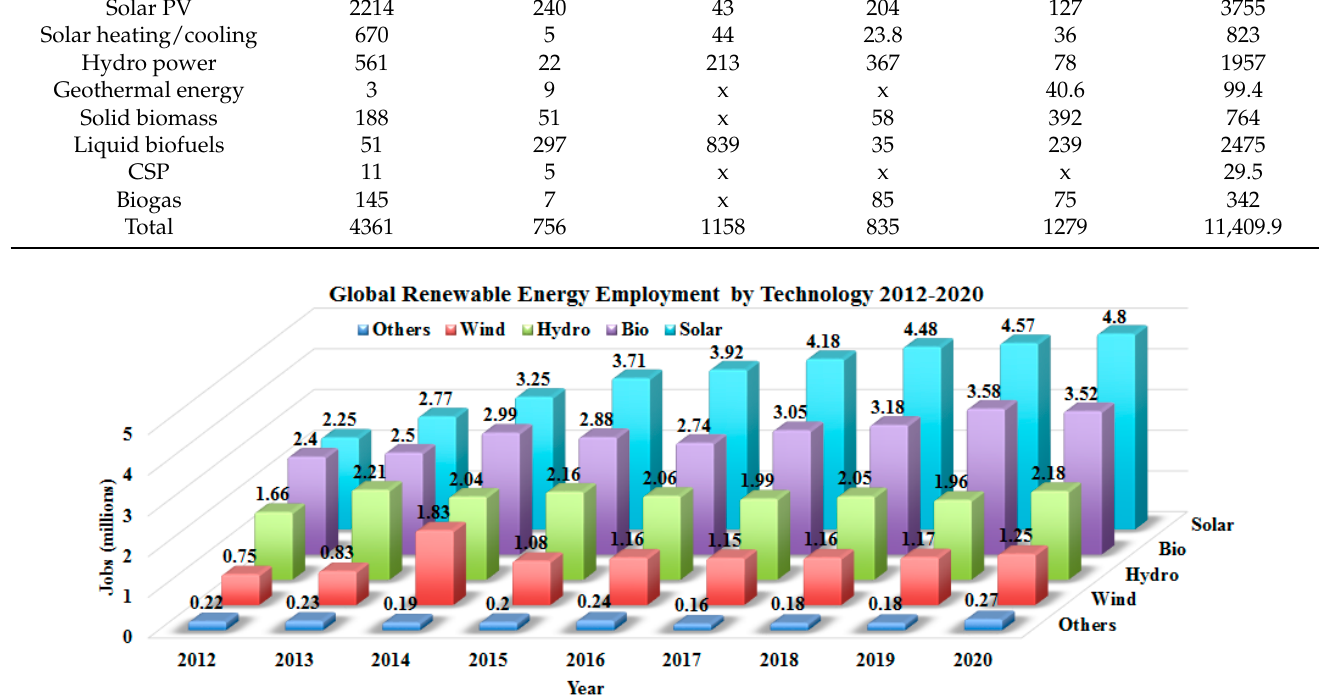
Figure 6. Global employment in the field of renewable energy (2012–2019). Source: Renewable Energy and Jobs [28]. Table 1. Global status of jobs in the renewable energy industry in 2019. Source: Renewable Energy and Jobs [28]. Where, x = data is available.